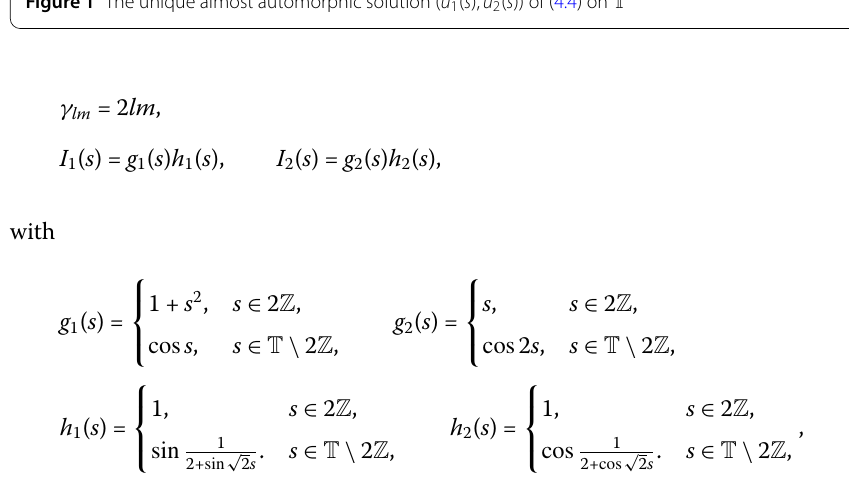
Figure 1 The unique almost automorphic solution ( u 1 ( s ), u 2 ( s )) of (4.4) on